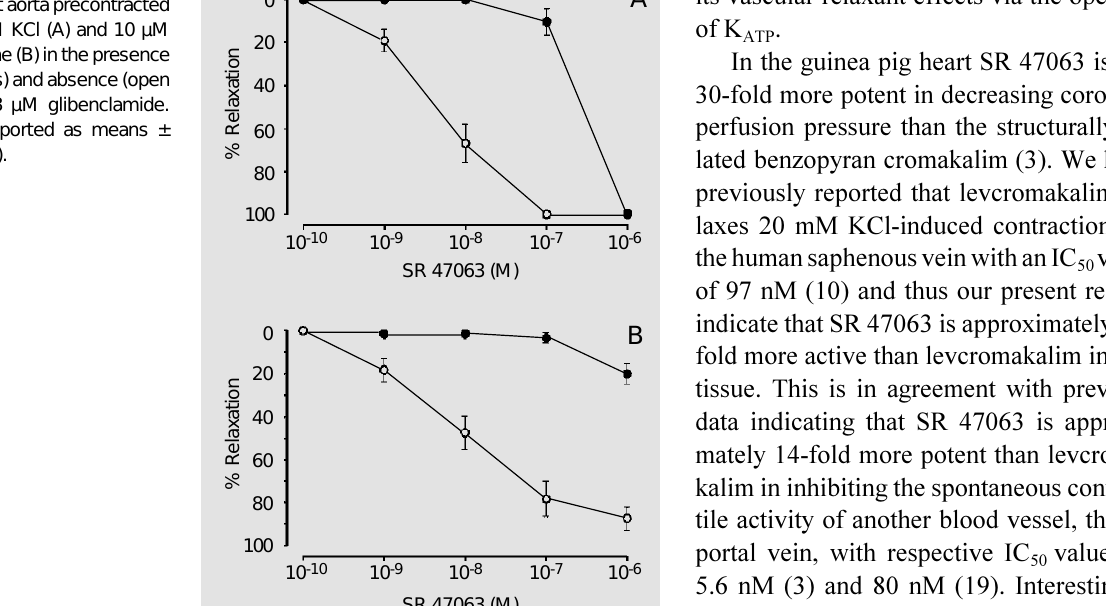
Figure 2 - Relaxant effects of SR 47063 on rat aorta precontracted with 20 mM KCl (A) and 10 µM noradrenaline (B) in the presence (filled circles) and absence (open circles) of 3 µM glibenclamide. Data are reported as means ± SEM (N =